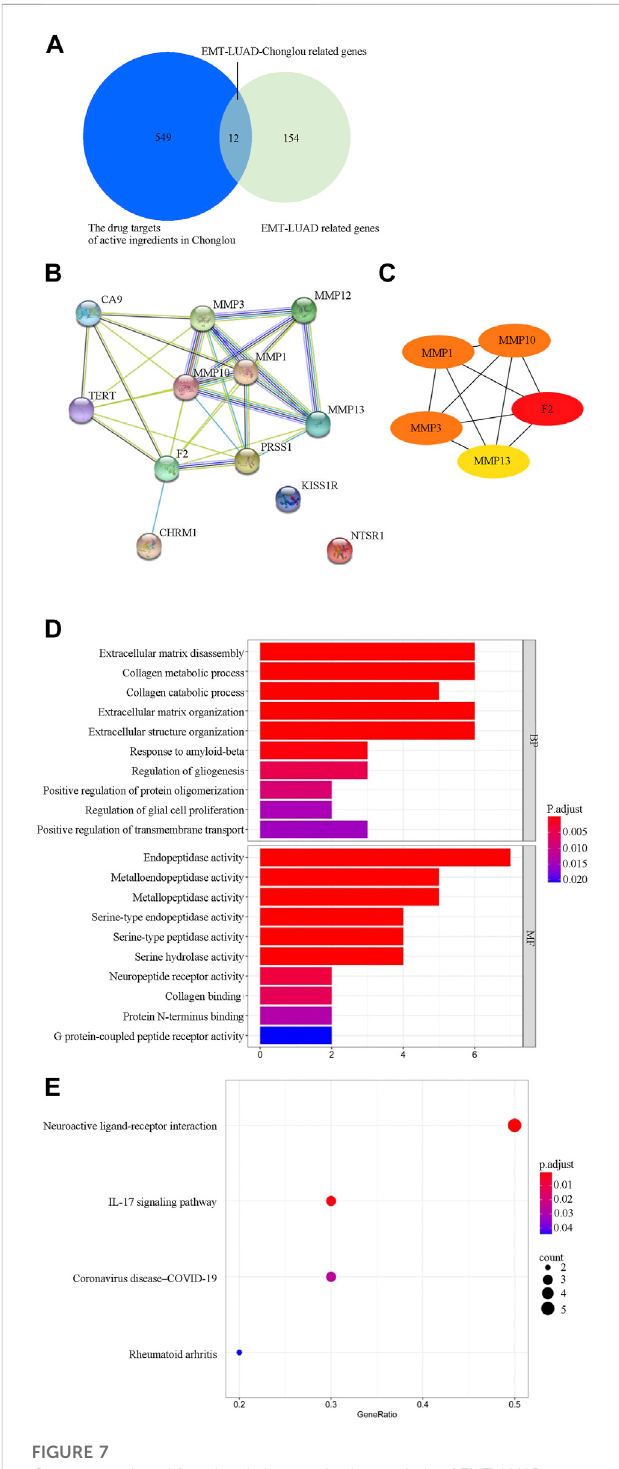
FIGURE 7 Gene network and functional characterization analysis of EMT-LUAD- Chonglou related genes. (A) Venn diagram depicts the cross section of the key drug targets of active ingredients in Chonglou and EMT-LUAD related genes. (B) STRING analysis indicating protein – protein interaction networking mediated by the EMT-LUAD-Chonglou related genes (The nodes represent proteins, the node labels are the protein names, and the connecting lines between the nodes indicate the existence of interactions between the proteins). (C) Cytoscape analysis representing the protein interaction network. Five core targets (F2, MMP1, MMP3, MMP10, and MMP13) are highlighted. (D) Gene ontology analysis of EMT-LUAD- Chonglou related genes. (E) Kyoto Encyclopedia of Genes and Genomes (KEGG) pathway of EMT-LUAD-Chonglou related